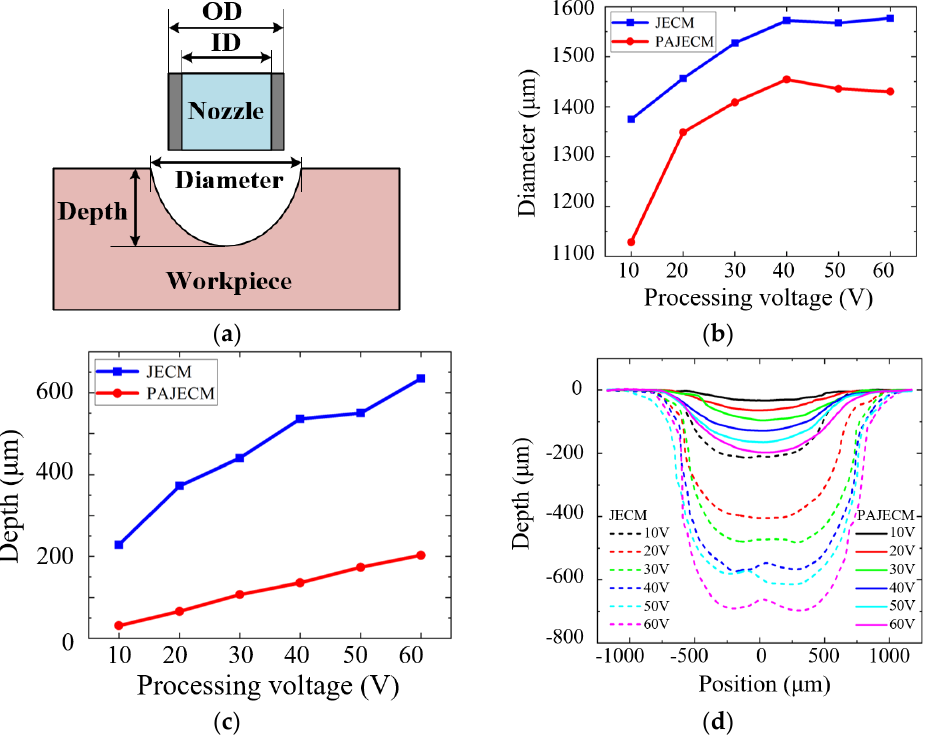
Figure 7. Diameter and depth of dimples processed by different processes: ( a ) schematic diagram of dimples; ( b ) dimple diameter; ( c ) dimple depth; ( d ) cross−section profile.